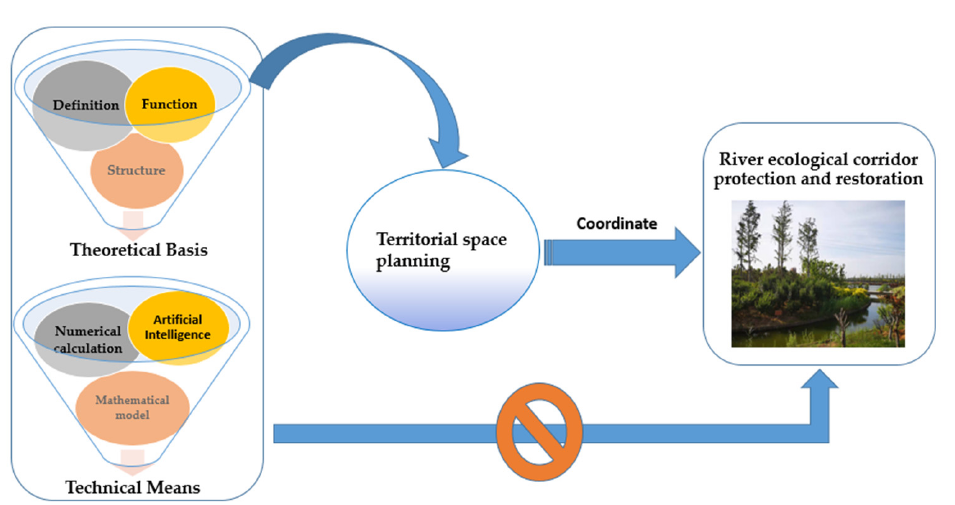
Figure 1. A diagram of the coordination relationship between the research on the scope definition of the river ecological corridor and the territorial spatial planning. The research on the scope definition of the river ecological corridor is carried out in combination with theoretical basis and technical means. It is necessary to coordinate with territorial spatial planning to effectively protect and restore the river ecological corridor.